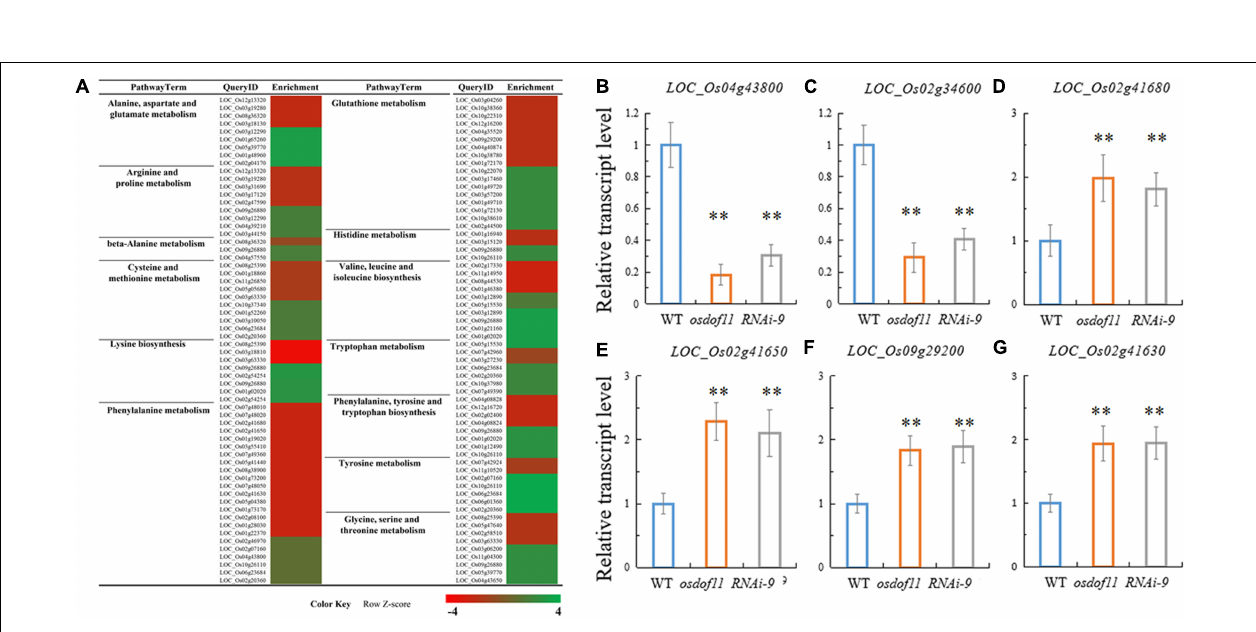
FIGURE 5 | Transcription analysis of N-related genes in WT and OsDOF11 mutants. (A) Microarray analysis of amino acid-related genes in WT and OsDOF11 mutants. (B–G) Expression levels of N assimilation genes relative to OsUBQ5 evaluated at flowering stages in leaf blades. (B) LOC_Os04g43800; (C) LOC_Os02g34600; (D) LOC_Os02g41680; (E) LOC_Os02g41650; (F) LOC_Os09g29200; (G) LOC_Os02g41630. Each data point represents the mean ( ± SE) from at least four different plants. ** P <